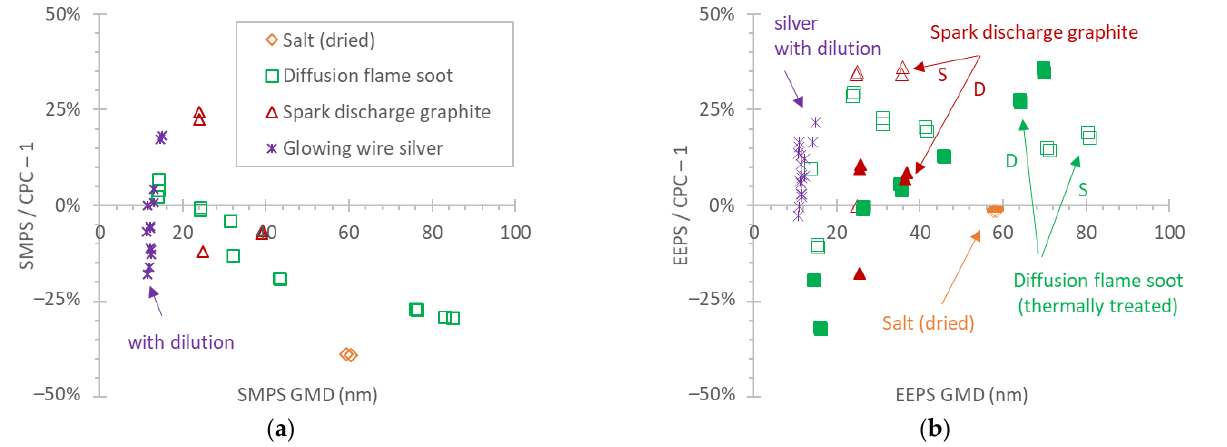
Figure 5. PN concentration ratio (SMPS or EEPS to CPC) in function of the geometric mean diameter (GMD) for various materials: ( a ) SMPS; ( b ) EEPS. “D” refers to the “Default” EEPS matrix (solid symbols), “S” refers to the “Soot” EEPS matrix (open symbols). CPC in photometric mode, except silver points indicated “with dilution”.